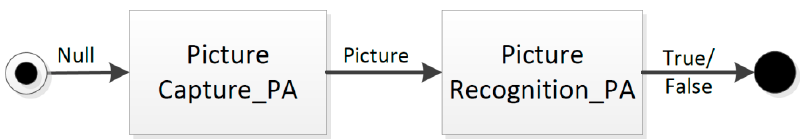
Figure 1. Structure of the presence awareness